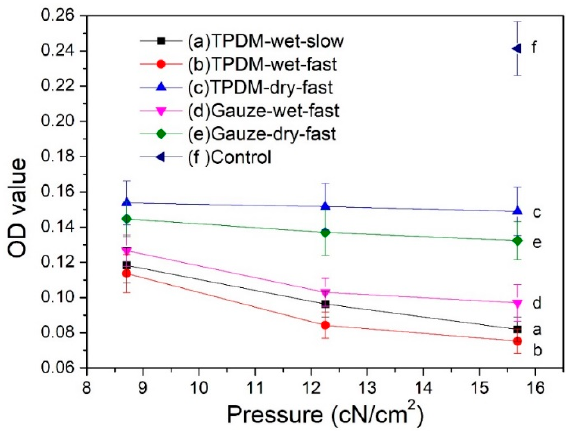
Figure 13. MTT results for in vitro biofilm removal tests.